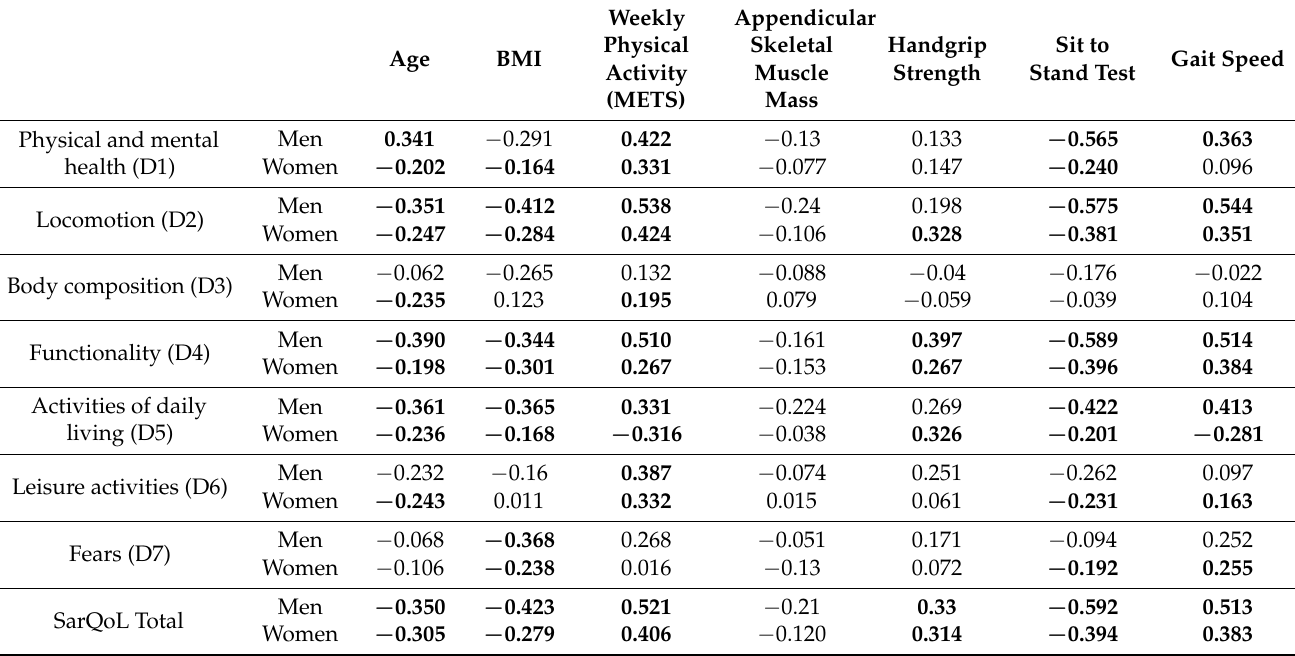
Table 2. Correlations between principal variables related with Sarcopenia and SarQoL